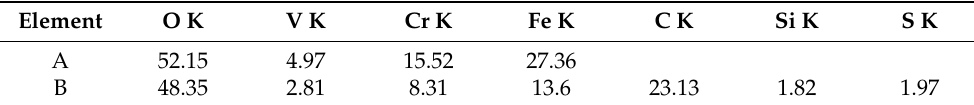
Figure 5. SEM images of the ingots from induction furnace (( A ): spinel, ( B ): complex structure). Table 7. Element contents in nonmetallic substance (EDS, atom%).